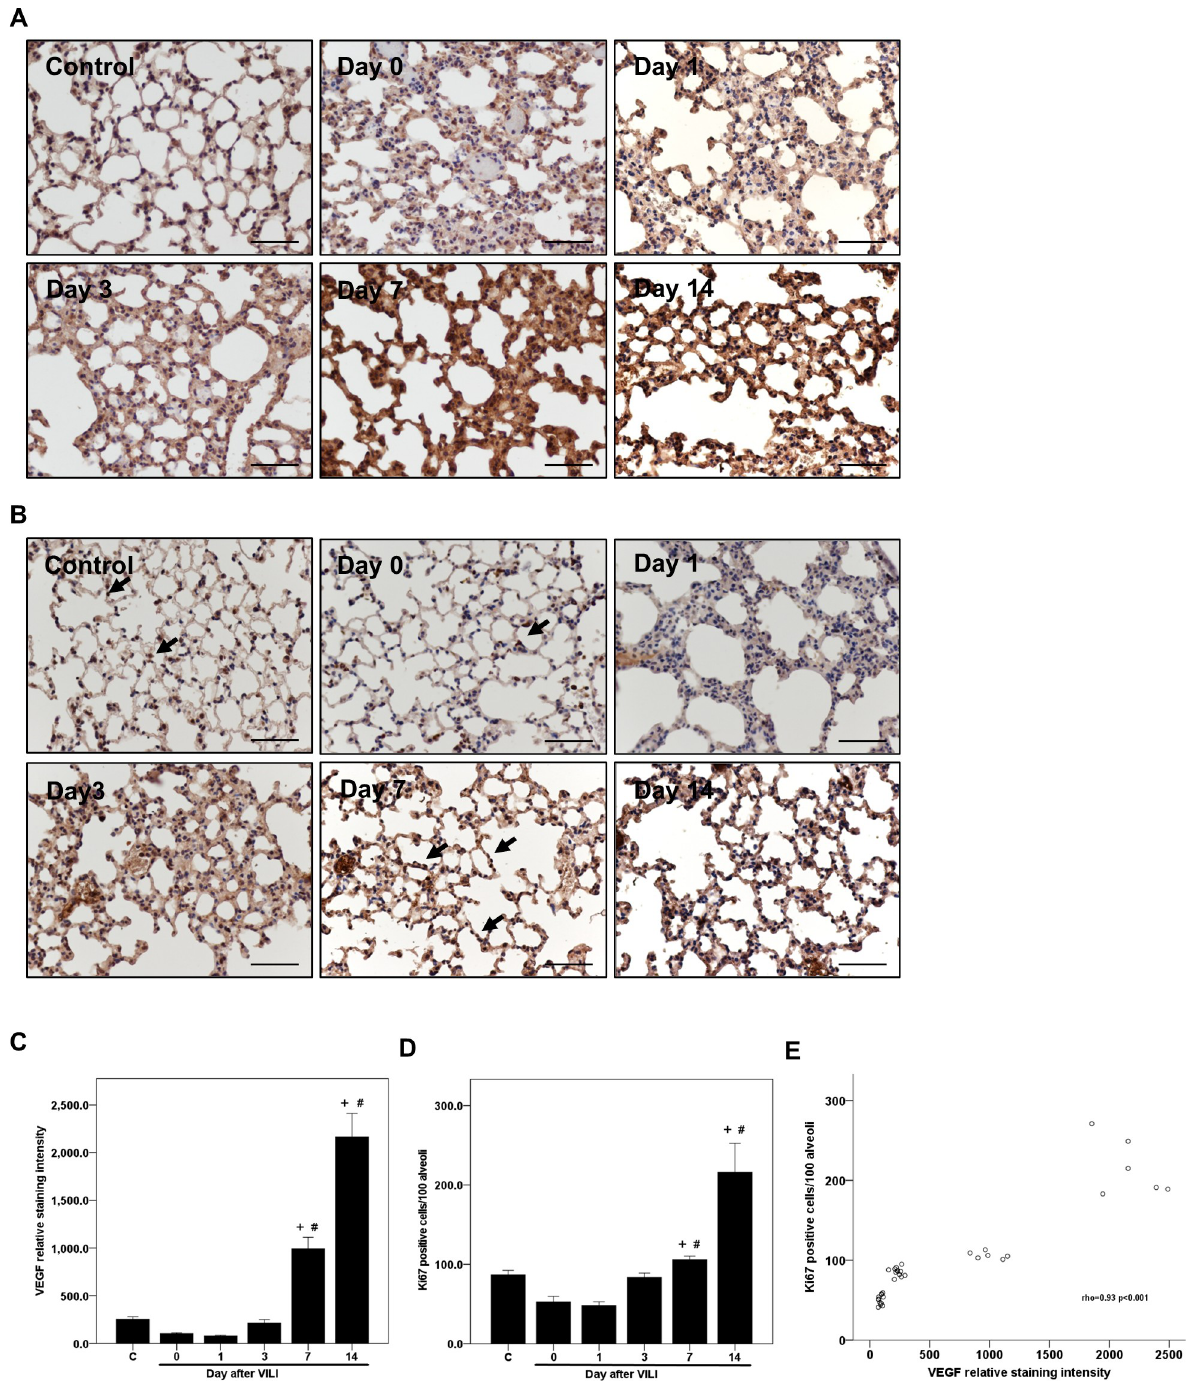
Fig 4. Immunocytochemistry for VEGF and Ki67 in lung sections of mice following VILI. C57BL/6 mice received 20 ng LPS intraventricularly and HTV ventilation to produce a two-hit VILI. The mice were sacrificed immediately after VILI (day 0) or on day 1, 3, 7, or 14 after VILI. (A) Immunocytochemistry (IHC) for VEGF in mouse lung sections. (B) IHC for Ki67-positive cells of the alveolar epithelium in mouse lung sections. The closed arrow indicates Ki67-positive cells in the alveolar epithelium. (C-D) Histometric analysis of the time courses of VEGF expression and the number of Ki67-positive cells in the lung alveolar epithelium. Scale bar = 200 μ m. Statistical analysis was performed using the Kruskal-Wallis test with Bonferroni correction. Data are expressed as means ± SD; n = 6 per group, p < 0.05 + vs. day 0 and # vs. day 1; normal control (C). (E) Correlation between the VEGF relative staining intensity and the number of Ki67-positive cells per 100 alveoli (Spearmen’s correlation coefficient rho = 0.93, p < 0.001).